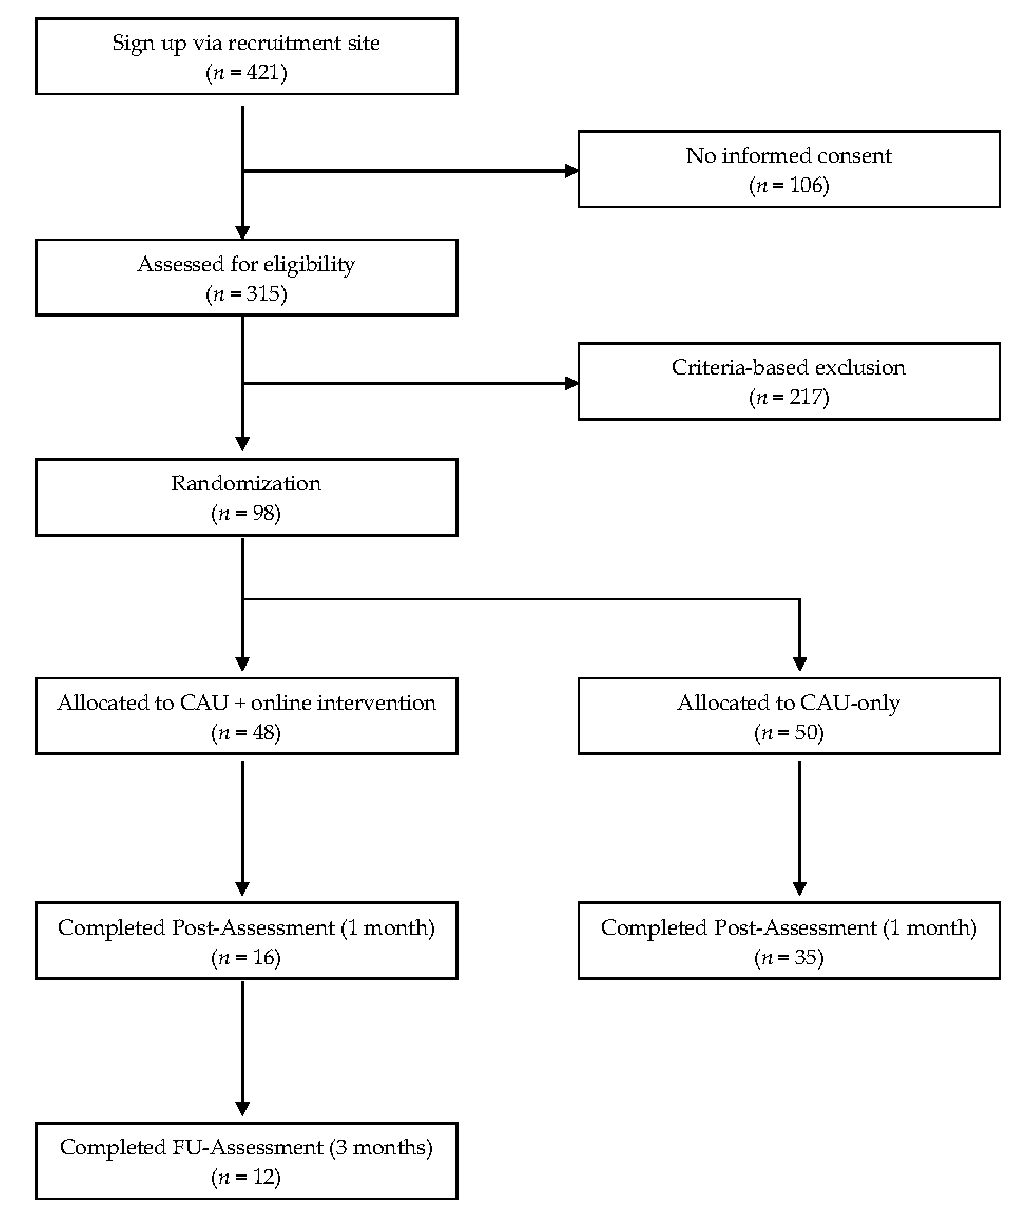
Figure 1. Participant flow.